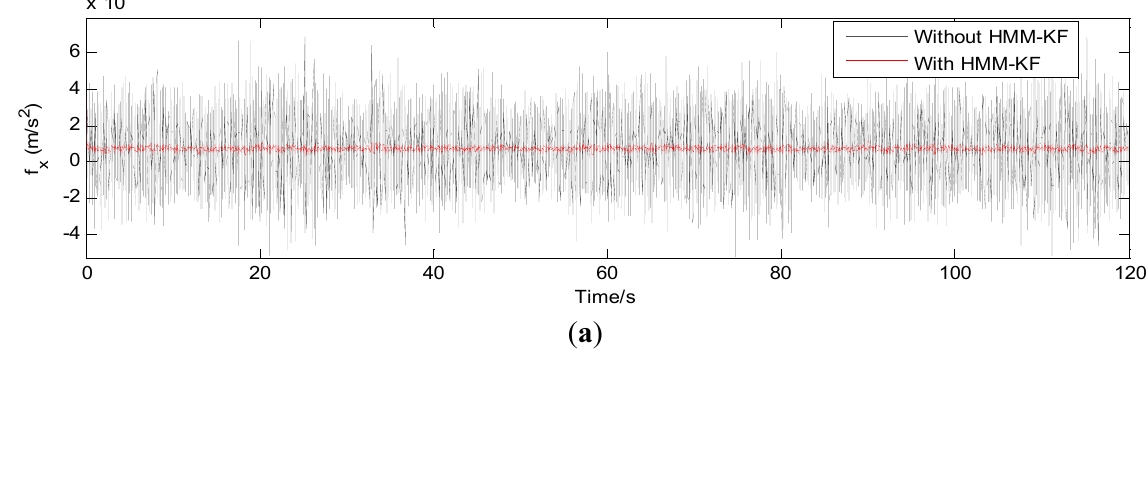
Figure 4. Time-domain analysis of the accelerometer outputs with and without HMM-KF ( a ) x axis accelerometer; ( b ) y axis accelerometer; ( c ) z axis